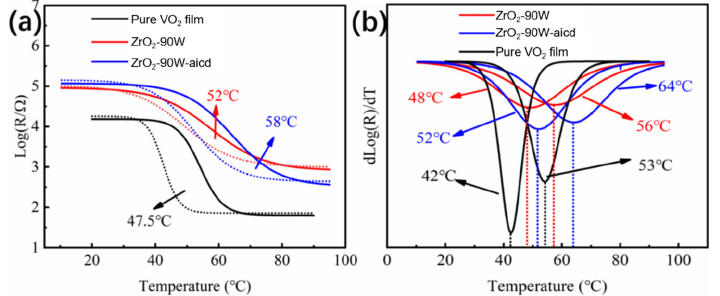
Figure 8. The electrical hysteresis loop ( a ) and the corresponding differential curves ( b ) of pure VO 2 film, sample ZrO 2 -90 W, and sample ZrO 2 -90 W-acid. Table 3. Comparison of thermochromic performance of this work with previous works.